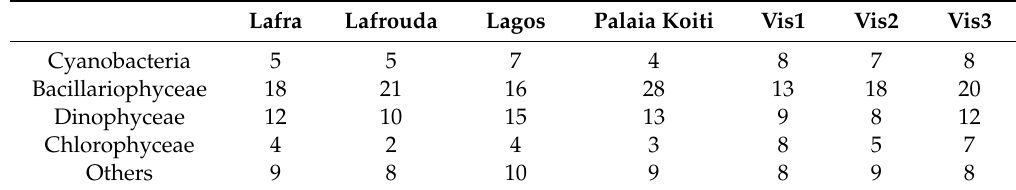
Table 2. Number of species for each phytoplankton taxonomic group in Lafra, Lafrouda, Lagos (Lag), Palaia Koiti (PK) and Vistonis (Vis1, Vis2, Vis3)